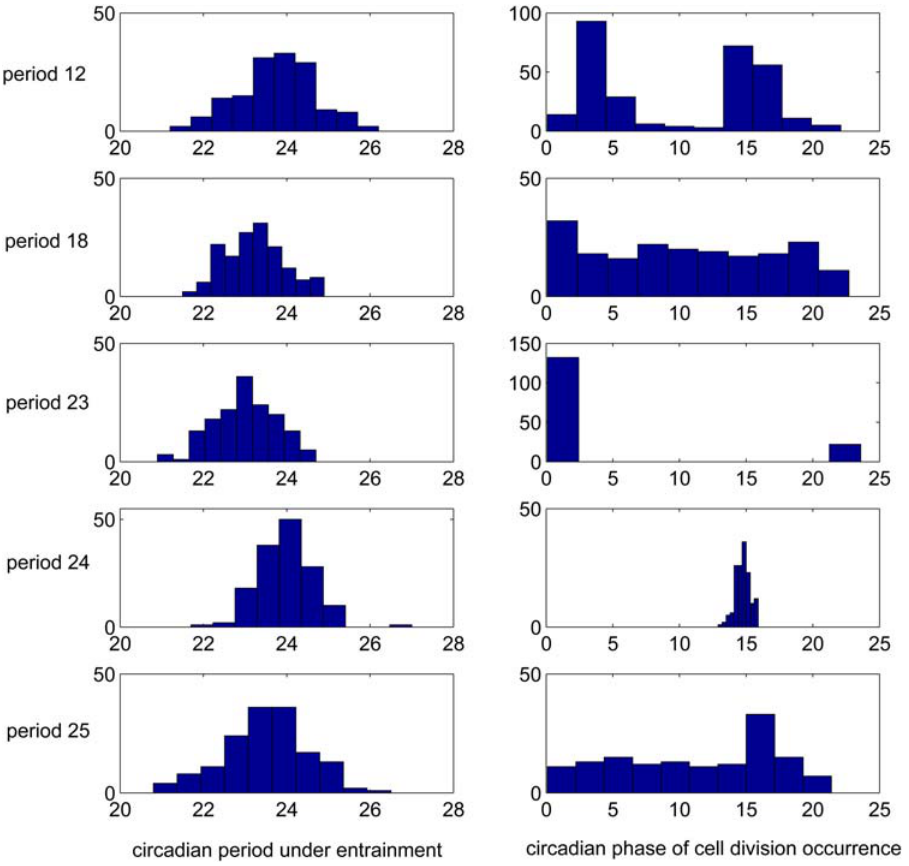
Figure 7. Entrainment of circadian clock by cell cycles of different periods at constant darkness in the presence of molecular noise. The effects of the cell cycle period on the entrainment in the presence of noise were studied by changing the periods of the square waves imposed onto the circadian model with noise. The periods of the coupled model and the circadian phases (with the peak of Per mRNA as the reference phase) where the troughs of the square wave occurred are determined. The distributions of the resulting circadian periods and the phases of transcriptional inhibition occurrence resulting from one simulation are displayed here.